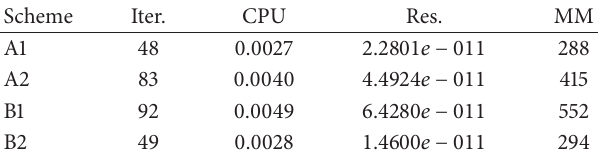
Table 2: Numerical results of Example